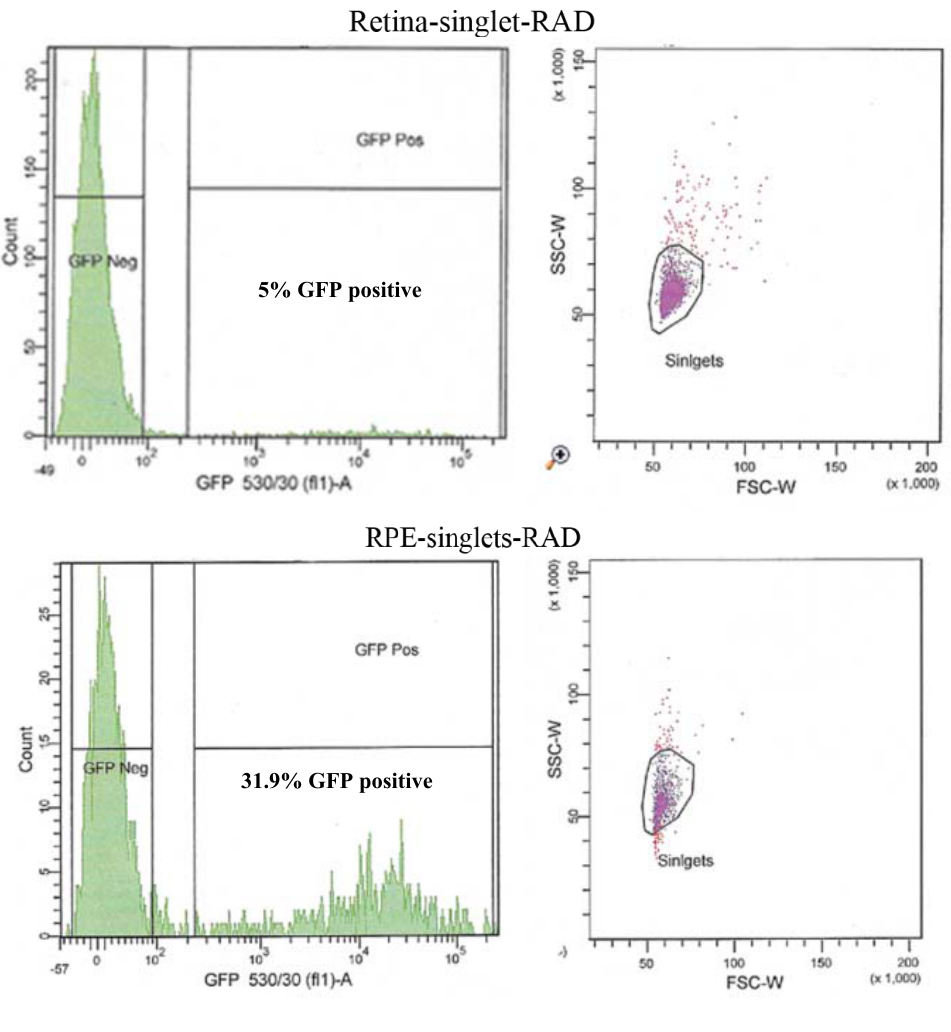
Figure 6. FACS analysis of the effect of peptides on the cellular transduction pattern following co-subretinal injection with AAV2/5 (CMV-eGFP) in adult mice. Only 5% of retinal cells coinjected with RAD peptide control are positive for eGFP compared to 11.2% of eGFP-positive retinal cells coinjected with RGD. By contrast RPE cells from RAD-injected mice are 31.9% positive for eGFP compared to only 2.7% eGFP-positive RPE cells in the RGD